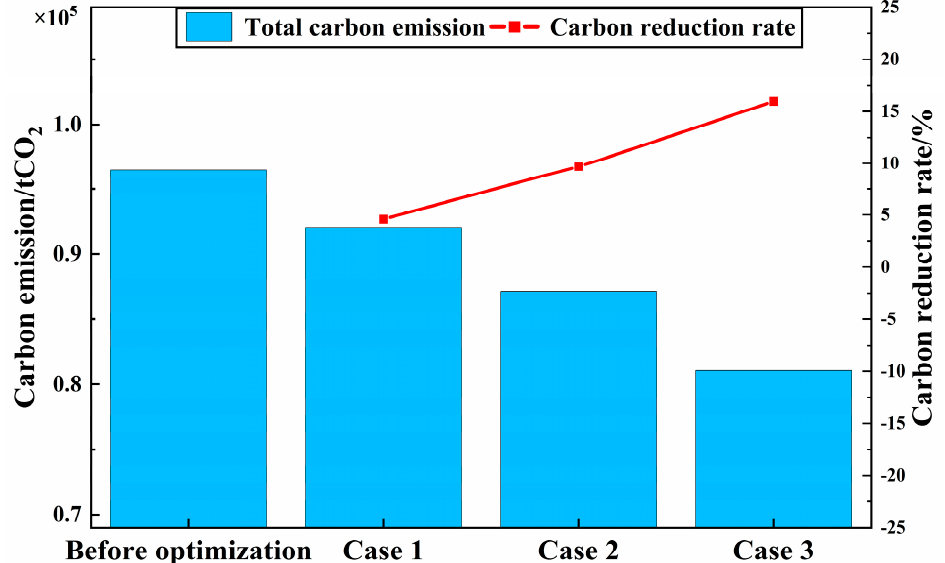
Figure 12. Total carbon emissions and carbon-reduction rates in the three cases and before optimi- zation.